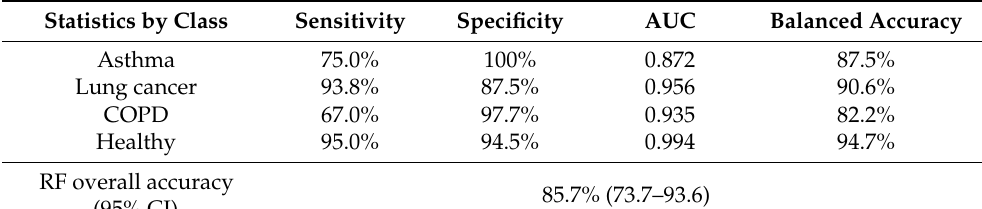
Figure 4. ( a ) Variable importance plot in terms of mean decrease Gini (node purity), obtained in the first training of RF model. Diamonds refer to VOCs selected for generation of the final classificatory model; ( b ) ROC curves based on RF’s final model output regarding the test set, using a panel of 12 VOCs; ( c ) Example decision tree produced by RF analysis, in which obtained accuracy was 81% (AS = asthma, CA = lung cancer, COPD = chronic obstructive pulmonary disease, H = healthy). Table 2. RF model performance (AUC = area under the curve, CI = confidence